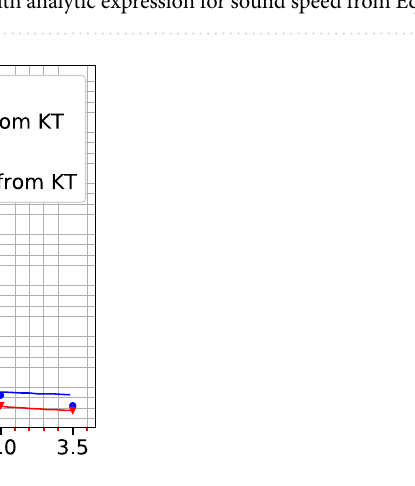
0 limit for a 3D system with results from Khrapak and →